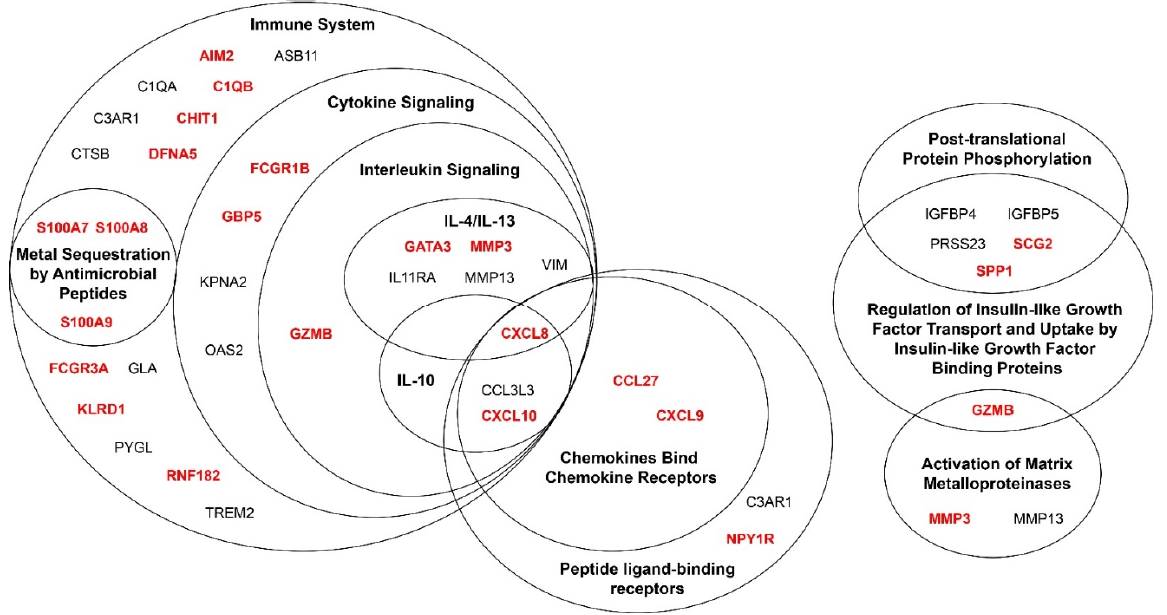
Figure 5. Genes associated with melanoma progression show significant enrichment of multiple pathways related to the immune system. Pathway enrichment was performed using Reactome’s over-representation analysis on a combination of genes identified by the following analyses: (1) top ten differentially expressed gene in melanoma progression in at least one dataset (Figure 1); (2) gene identified in at least one binomial regression model distinguishing nevi vs. cutaneous malignant melanoma (CMM) (Figure 2C–E); and (3) a significantly differentially expressed gene between nevi and CMM in at least two datasets (Figure 3). Genes colored in red and bolded represent genes that were differentially expressed between nevi and CMM in at least two datasets (Figure 3). A pathway was considered to be enriched if it had a Benjamini– Hochberg-adjusted p -value < 0.05 (corresponding to a false discovery rate < 5%). The eleven significantly